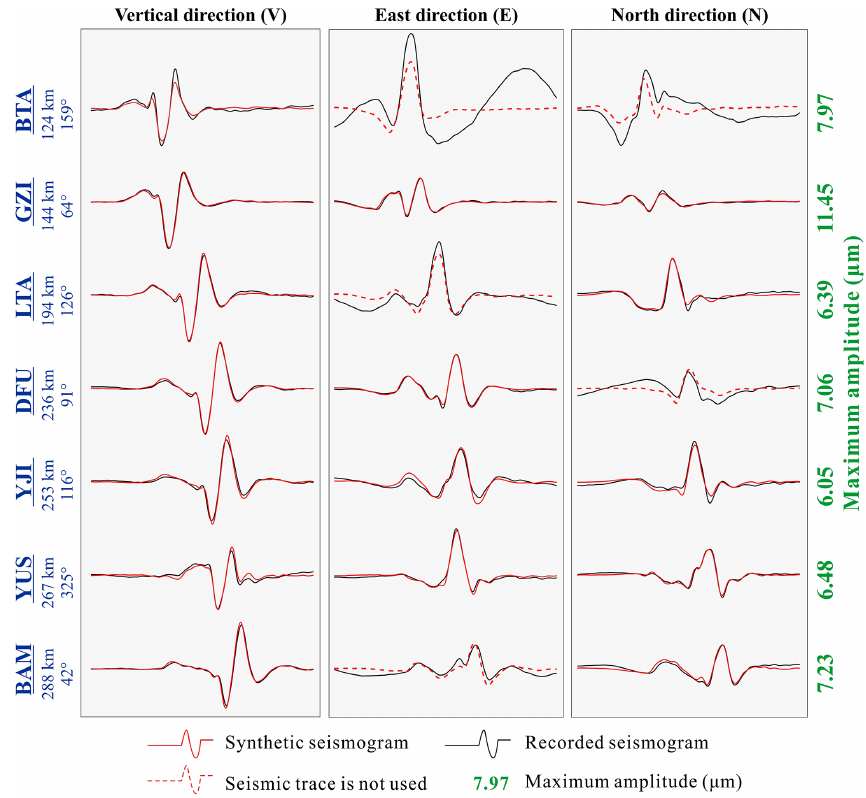
Figure 9. Seismograms of the Baige landslide. Synthetic (red lines) and recorded (black lines) seismograms are compared. Dotted red lines indicate that the seismic trace was not used in the inversion because their SNR is smaller than 10dB. Station name, distance from study site (km), and azimuth (degree) are given to the left of each trace (see Fig. 1d for locations), and the maximum amplitude of the three components is given (in µm) to the right.